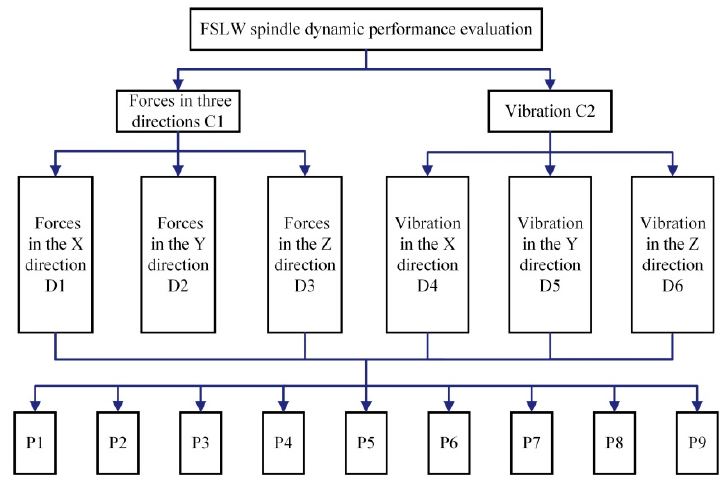
Figure 10. An analytic hierarchy process diagram.